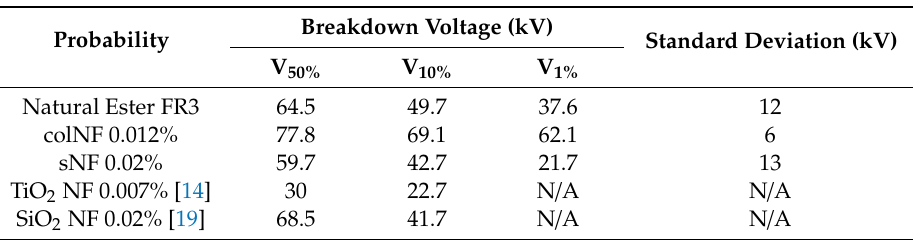
Table 1. Breakdown voltage